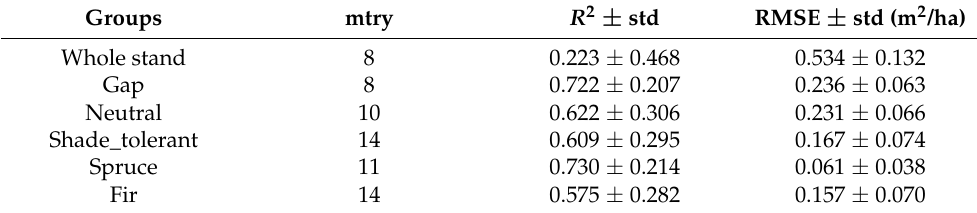
Table 4. Ten-fold blocked cross-validation results for the six groups.